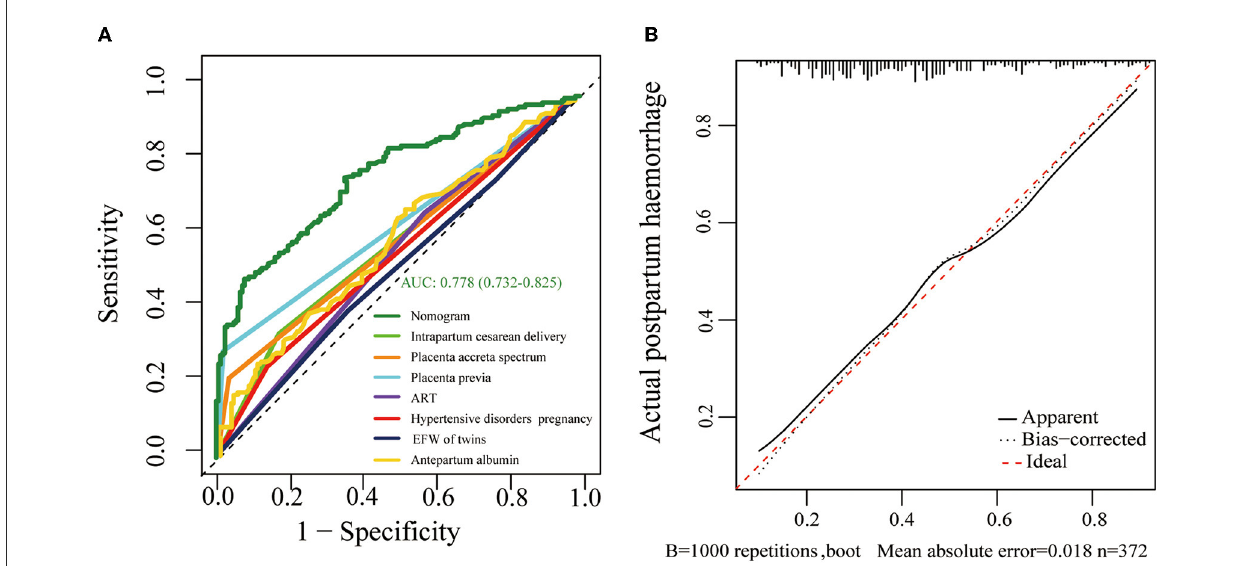
FIGURE3 (A) Receiver operating characteristic (ROC) curves of the formulated nomogram model. The nomogram of the area under the receiver operating characteristic curve (AUC) was 0.778 (95% CI 0.732–0.825). (B) Calibration curve delineates the goodness of fit between the predicted probability and the actual probability. The horizontal axis represents the predicted risk of postpartum hemorrhage, and the vertical axis represents the observed outcome of the event. The diagonal dashed line signifies the ideal prediction, and the dotted line shows the predictive performance of the nomogram.